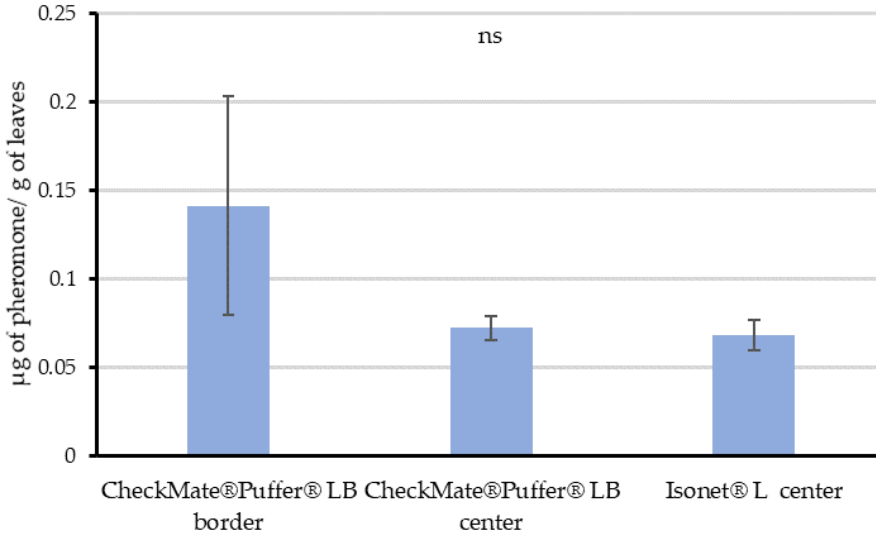
Figure 4. Mean (± SE) quantity of pheromone (µg pheromone/g leaves) adsorbed on leave samples of Experiment 3, collected in actual field conditions at Location 2: along the row where Checkmate devices were deployed (aerosol devices border), 70 m away from the aerosols row (aerosol devices center) and at the center of the Isonet passive dispensers treated field (passive dispensers center). Bars labeled with different letters are significantly different, ANOVA followed by the Fisher LSD test (F = 1.287; df = 2, 8; p > 0.05).